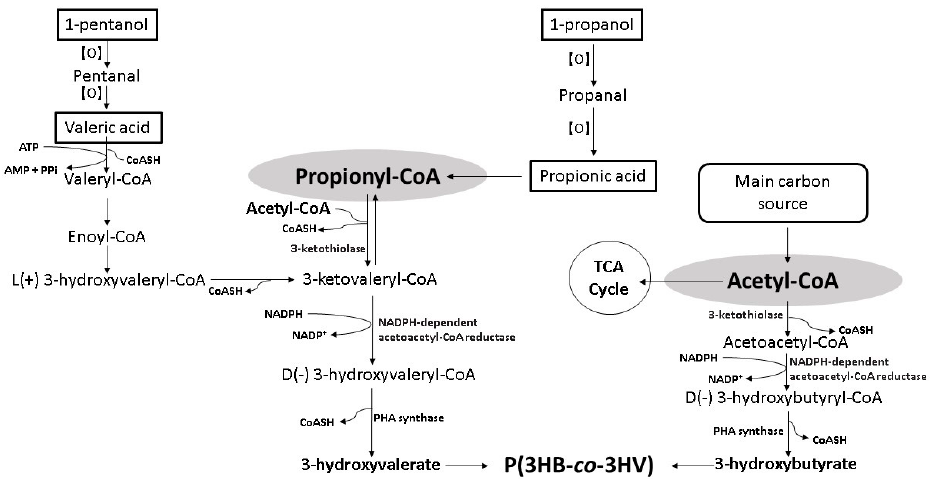
Figure 2. Schematic bioconversion pathway of organic acids and alkyl alcohols into 3HV [14,57– 60].